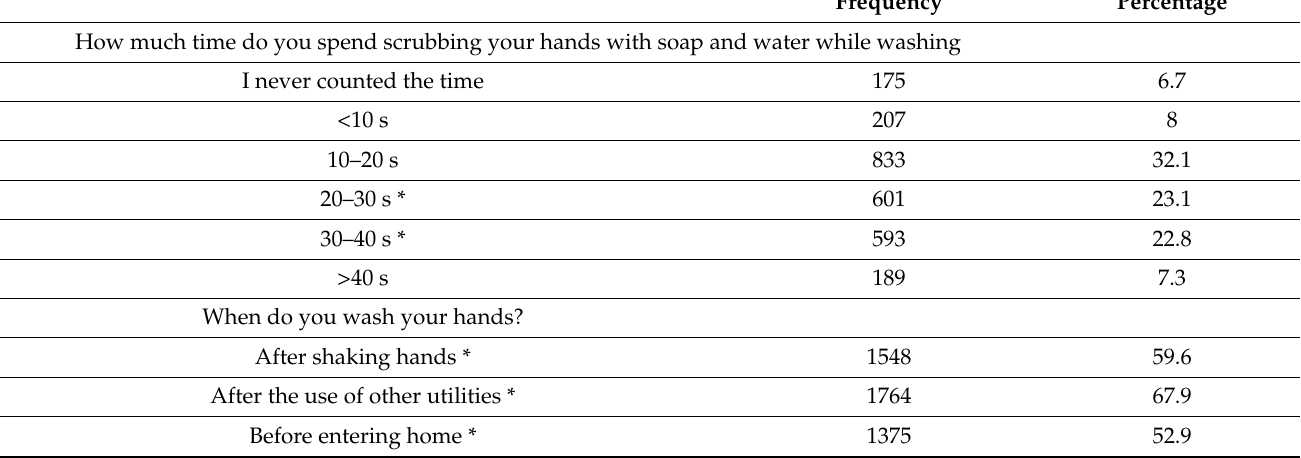
Table 2. The respondent’s hygienic and social distancing practices during the pandemic period. n =